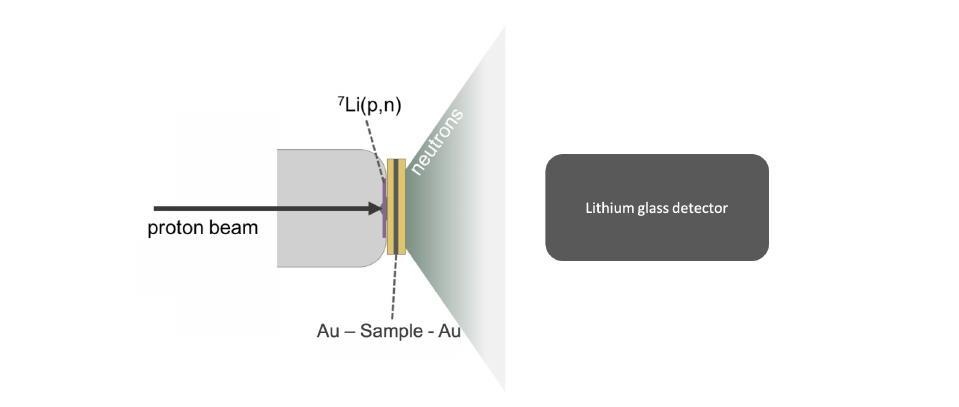
Figure 1. The proton beam impings on a lithium target where neutrons are produced via the reaction 7 Li(p,n). The neutrons pass the sample sandwich consisting out of the sample of interest which is surrounded by two gold foils. The gold foils acts as neutron monitors. A lithium glass detector is placed at zero degree in order to take account for beam fluctuations.